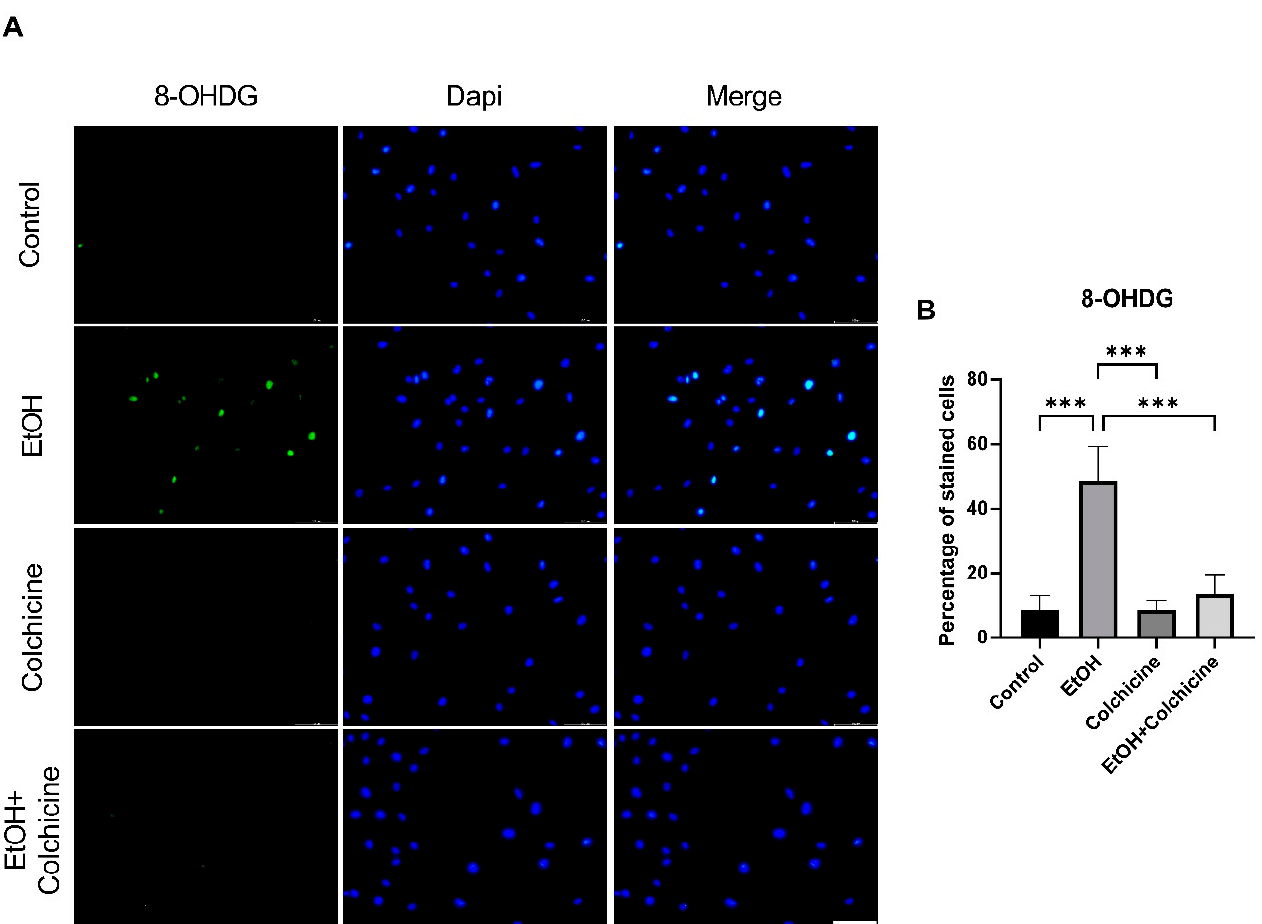
Figure 2. Colchicine restrained ethanol-induced oxidative stress in endothelial cells. ( A ) Immunofluorescence staining for oxidative stress marker 8-Hydroxydesoxyguanosin (8-OHDG) in endothelial cells 2 h after treatment with ethanol, colchicine, and ethanol combined with colchicine. Endothelial medium alone was used for untreated control. ( B ) Colchicine averted the expression of 8-OHDG in ethanol-treated cells. The experiment was performed with independent biological triplicates. The data was analyzed by performing one-way ANOVA followed by Tukey’s test. Scale bar = 100 µm; error bars represent the SD (*** p < 0.001).